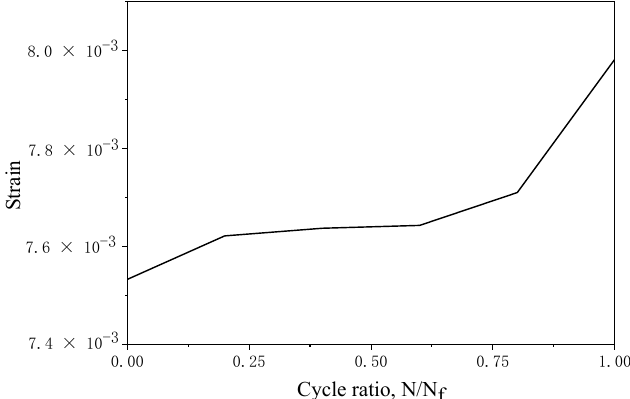
Figure 12. Strain variation of specimen in fatigue test that fractured in WNZ.